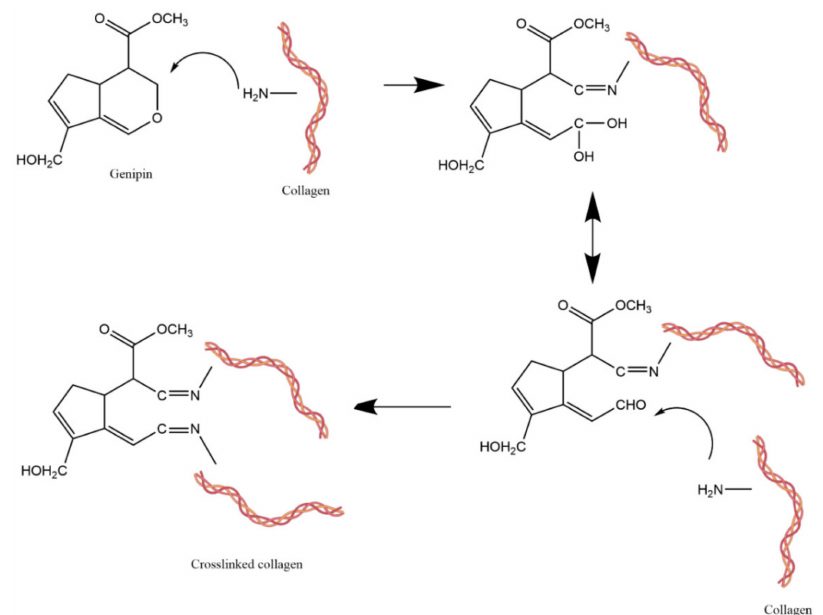
Figure 9. Chemical cross-linking of collagen using genipin